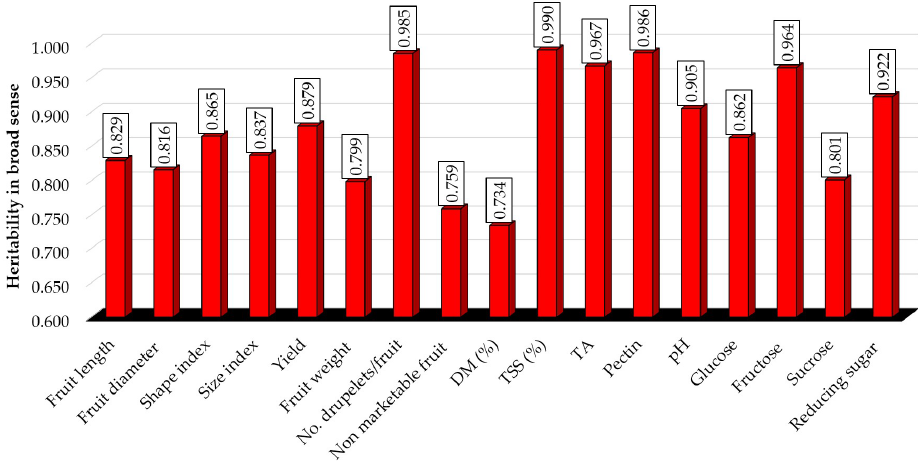
Figure 12. Broad-sense heritability of the 17 traits analyzed in the experiment with 14 raspberry hybrids. DM represents dry matter, TSS represents total soluble solids, and TA represents titratable acidity.